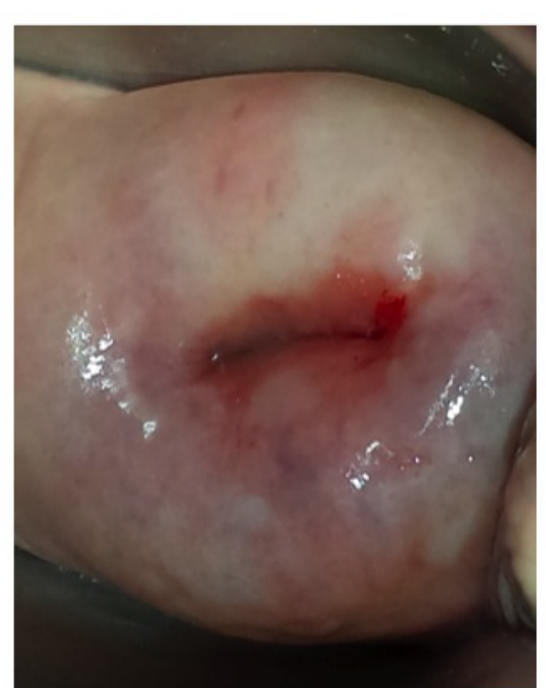
Figure 1. Digital visual inspection using acetic acid (D-VIA). Left. Native cervix. Right. Cervix after acetic acid